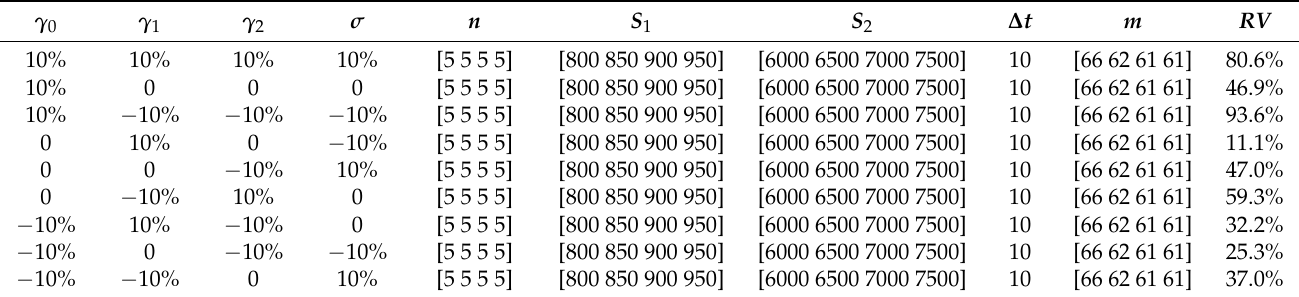
Table 19. Optimization results under different combinations of model parameter